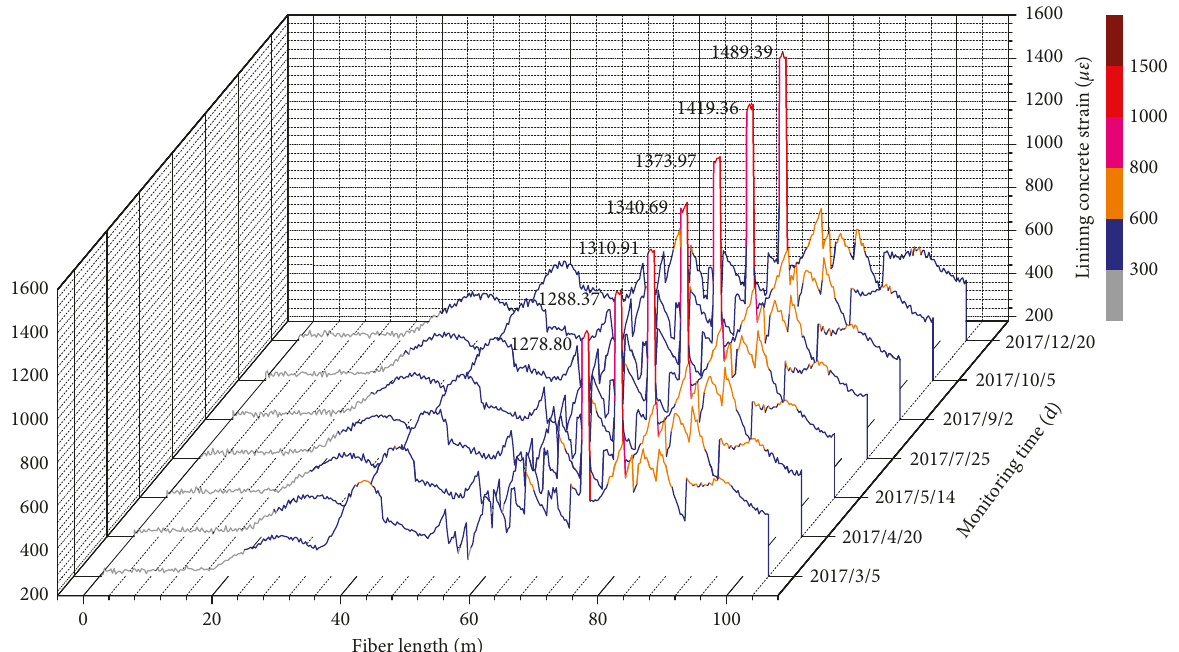
Figure 17: Tunnel lining concrete strain time space distribution (Color figure online).